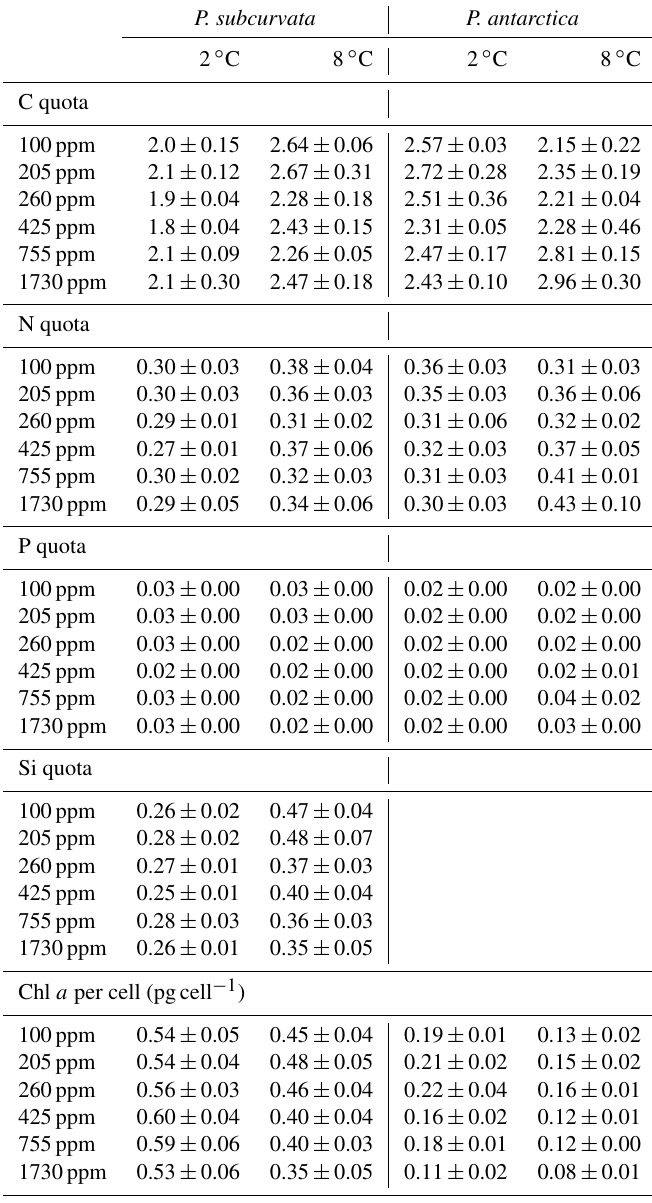
Table 6. The effects of CO 2 on the C quota (pmolcell − 1 ) , N quota (pmolcell − 1 ) , P quota (pmolcell − 1 ) , Si quota (pmolcell − 1 ) , and Chl a per cell (pgcell − 1 ) of P. subcurvata and P. antarctica at 2 and 8 ◦ C. Values represent the means and errors are the standard deviations of triplicate